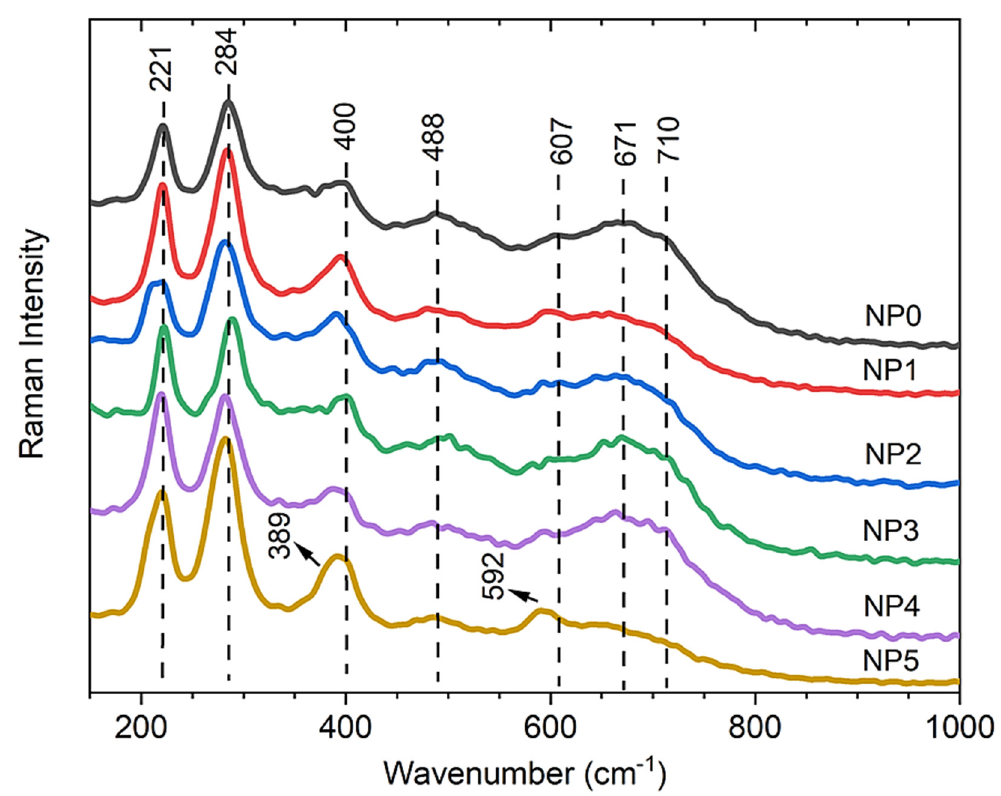
Figure 5. Raman spectra obtained with the power of 50 mW, in which the spectrum characteristic bands are predominant in the hematite phase.